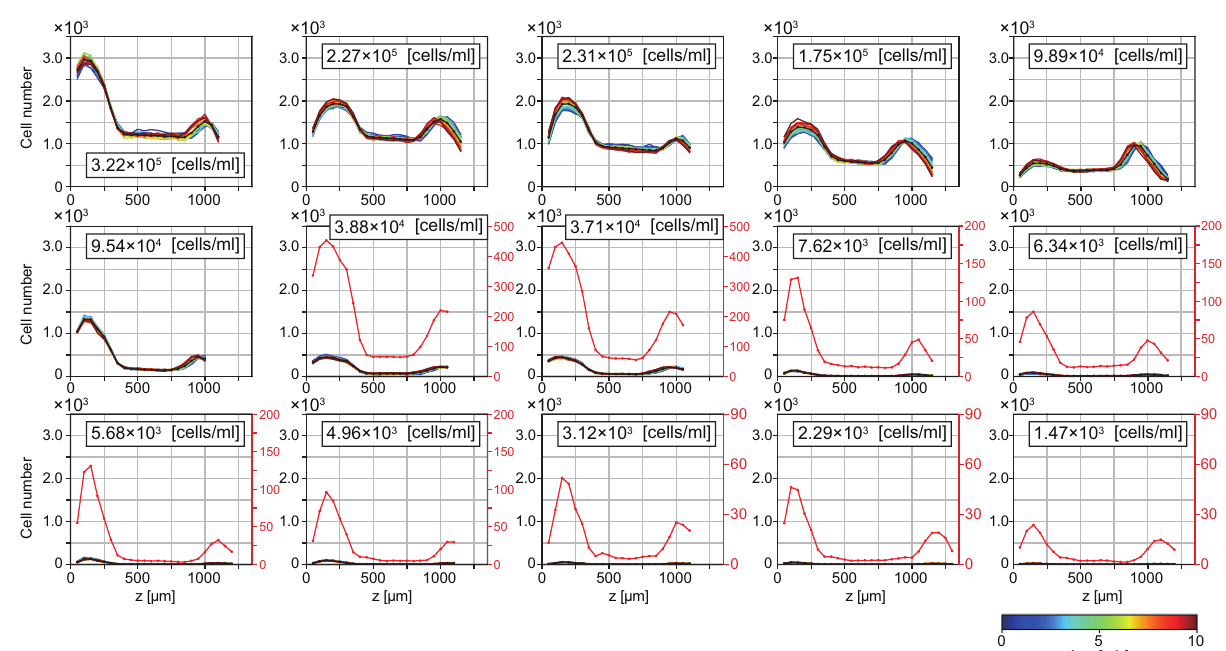
Figure 2. Spatial cell distribution of T. pyriformis suspension along the z -axis. Each plot displays the detected cell number as a function of height z from the bottom ( z = 0). The cell concentrations of the suspensions are described in the respective panels. The color map indicates the time evolution (every 30 s for 10 min), and the black line represents the time average. To show the details of the lines that are squeezed near zero, we have added the red lines to the panels corresponding to the concentration equal to or smaller than 3.88 × 10 4 cells/mL. The red line represents the same data as the black line with an expanded scale, as indicated by the red axis on the right side.